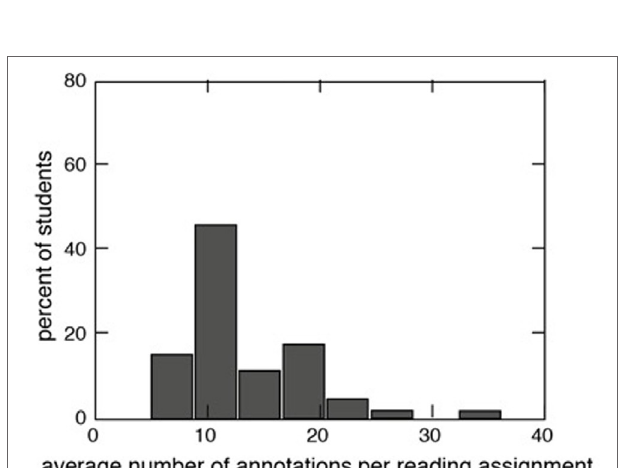
FigUre 12 | Histogram of the average number of reading sessions per assignment.